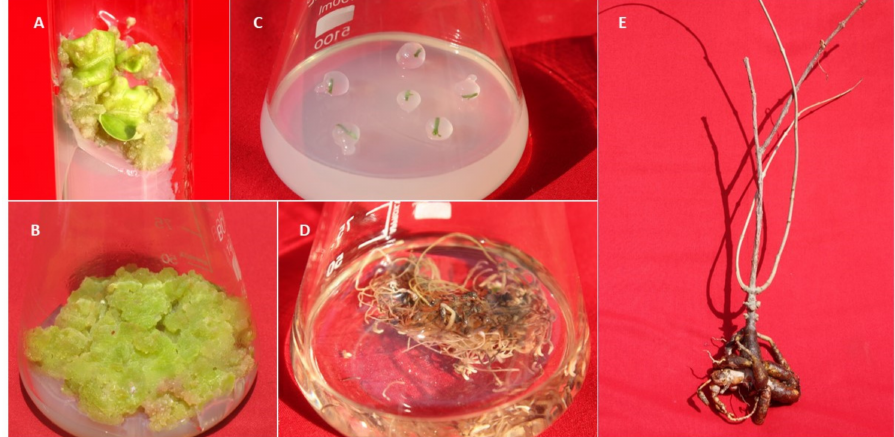
Figure 5. Callus formation derived from leaf explants of D. arayalpathra when cultured on MS medium supplemented with different PGRs. ( A , B ) D. arayalpathra leaf explant inoculated on MS + 1.0 µ M BA + 1.0 µ M NAA after 2 weeks and 6 weeks of culture, respectively. ( C ) Encapsulated NS on MS basal medium, 1-day-old culture. ( D ) Root culture. ( E ) Root tuber of D. arayalpathra